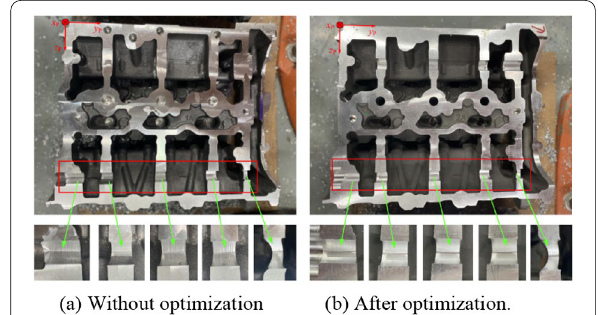
Figure 28 Comparison of milling results after configuration